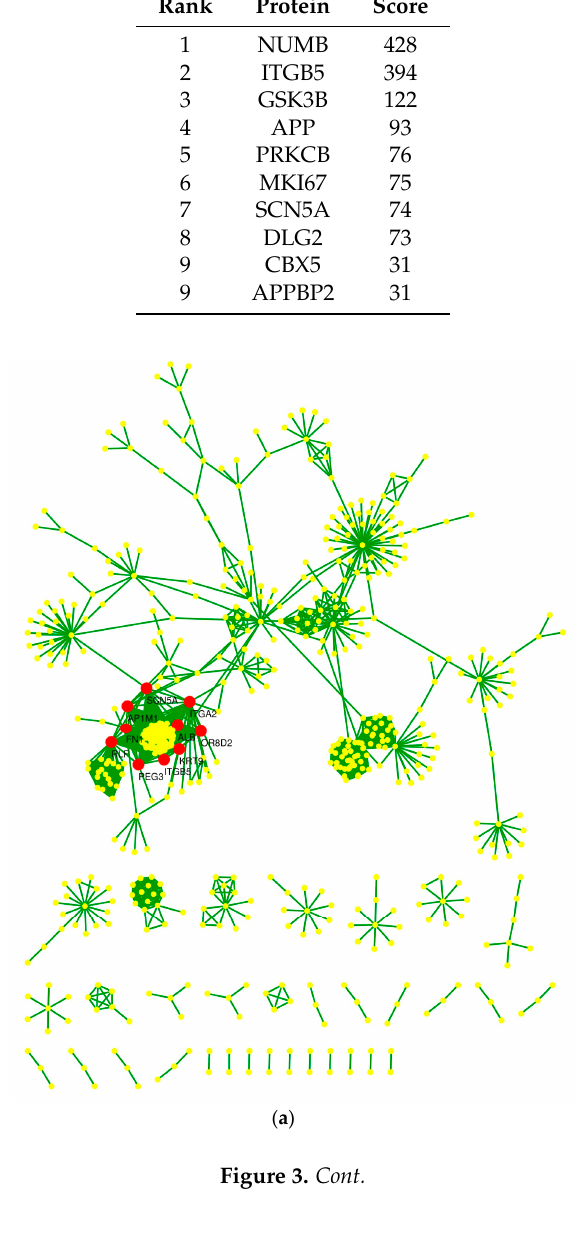
Table 4. Top 10 Hub nodes detected by Bottleneck method.